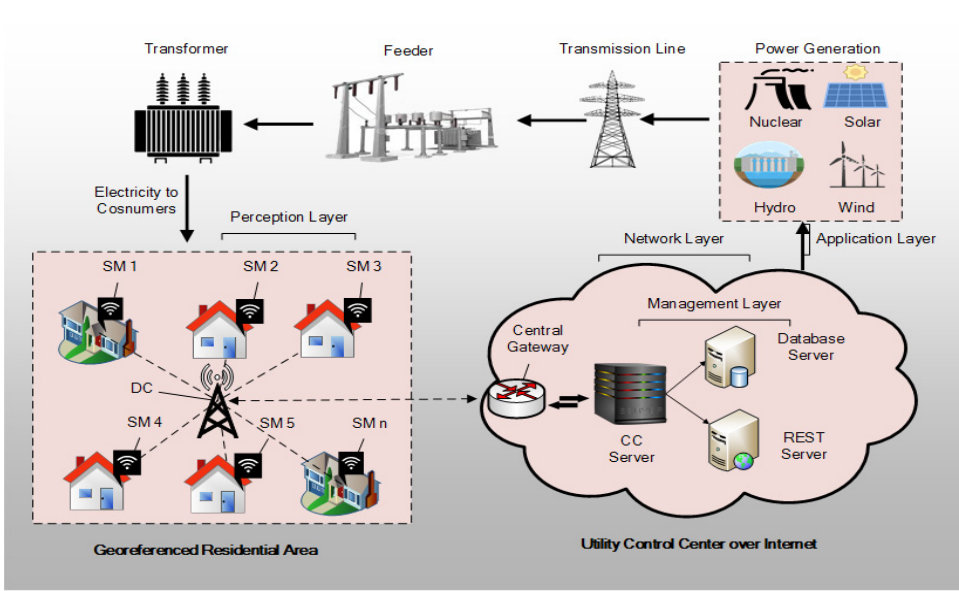
Figure 1. IoT-based general AMI example in smart grid (redrawn from [9]).